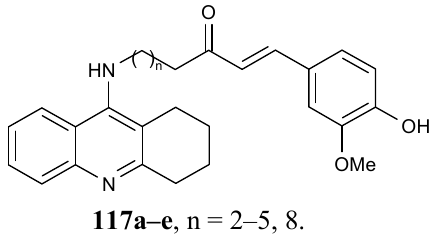
Figure 21. Tacrine-ferulic acid hybrids 117a–e .